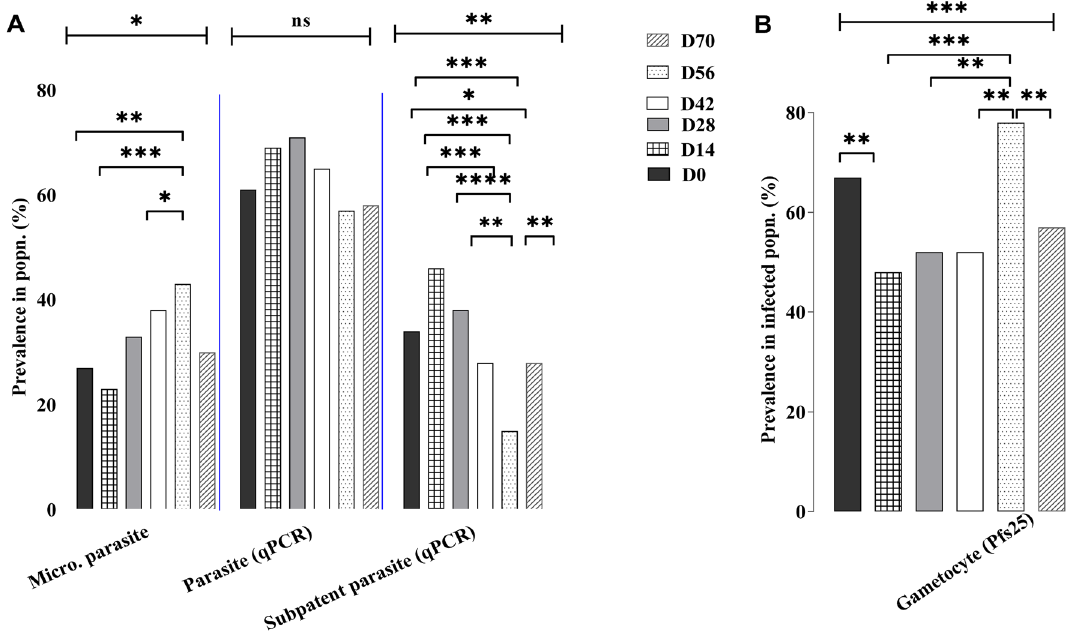
Figure 1. Plasmodium falciparum infection dynamics in the population. ( A ) The prevalence of parasites detected in the study population at each time point [Day (D)] using microscopy (Micro) and Pf 18srRNA reverse transcriptase-quantitative polymerase chain reaction [RT-qPCR (qPCR)]. Infections detected only by Pf18S rRNA using RT-qPCR, not microscopy were considered subpatent. Microscopic (Micro) parasite prevalence differed slightly (p = 0046) between sampling days. The prevalence of individuals infected only at the submicroscopic (Subpatent) level differed significantly (***p < 0.001) between time points. ( B ) Gametocyte prevalence detected in the infected population using Pfs25 RT-qPCR also differed significantly (***p = 0.007). Analysis for all time points was by Chi-square and between time points by two sample tests of